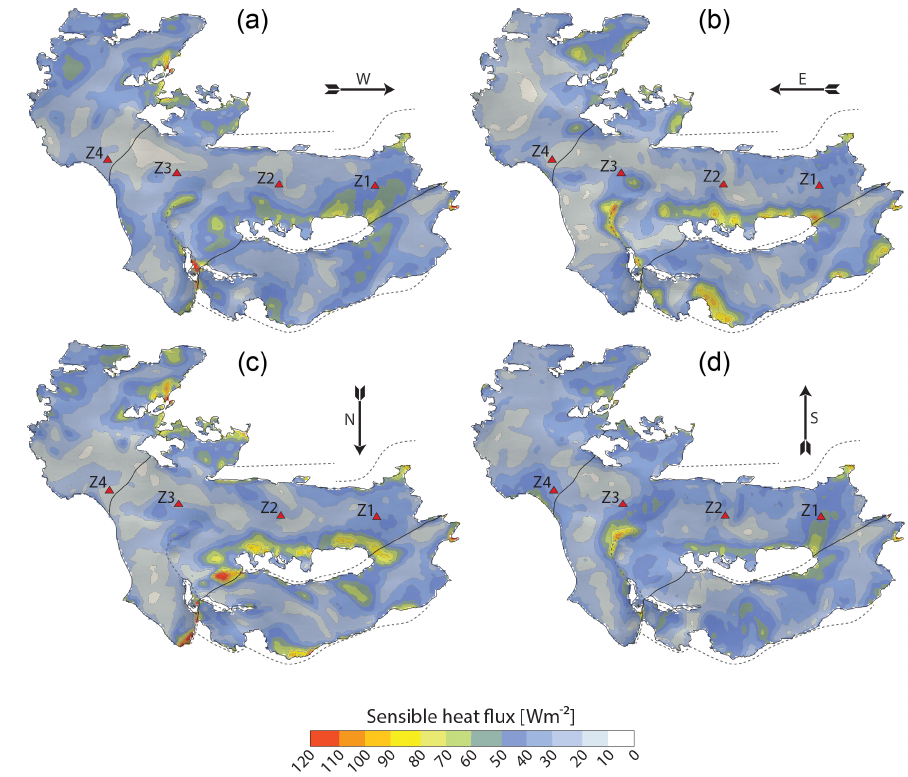
Figure 8. Mean sensible heat flux from the LES runs for each of the four case